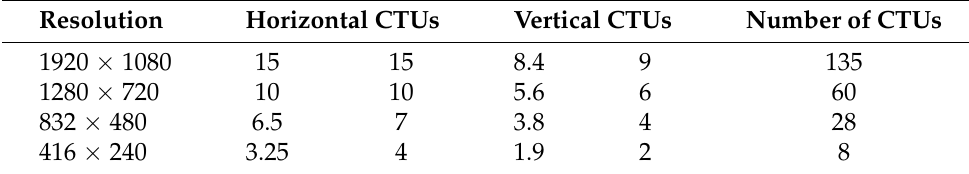
Table 4. Number of 128 × 128 CTUs for each video sequence